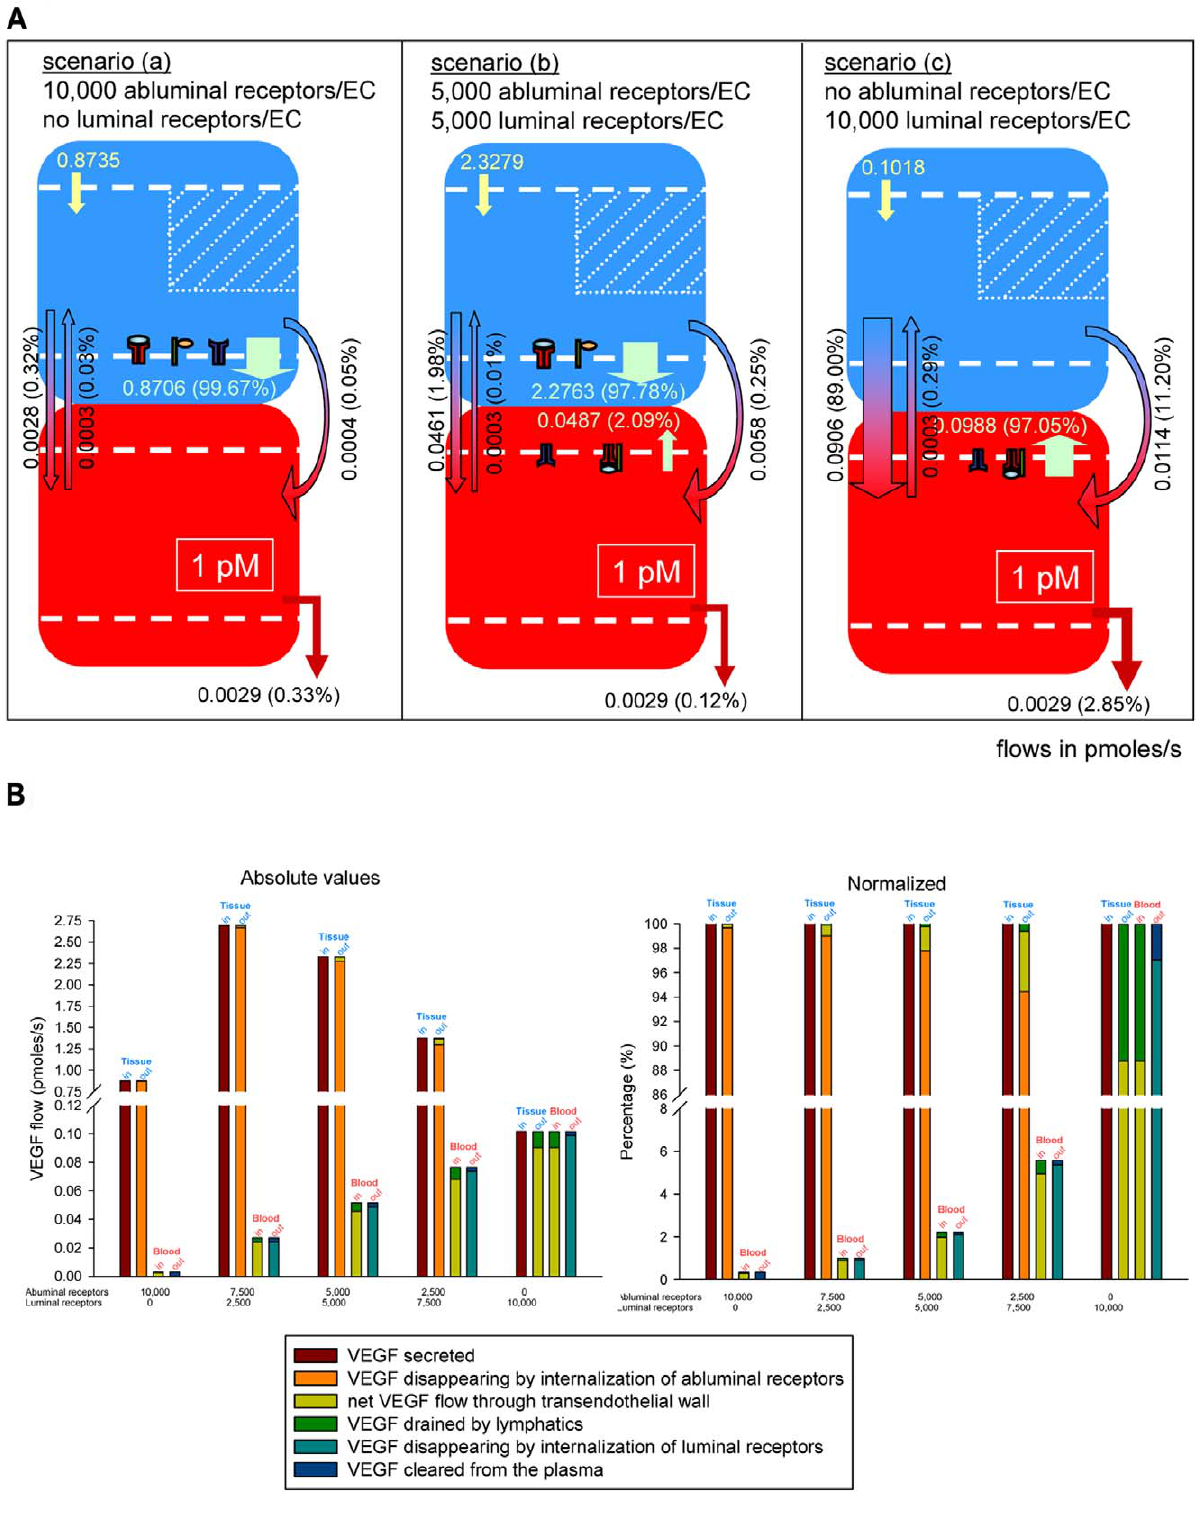
Figure 6. Flow diagrams for a total receptor density of 10,000 per endothelial cells. A. The density of total (luminal and abluminal) receptors per endothelial cell is fixed at 10,000 (VEGFR1:VEGFR2:NRP1 expression is 1:1:1). Scenario (a): all the receptors are located on the endothelial abluminal surface (yellow circle on Figure 4A); scenario (b): the receptors are evenly distributed between the luminal and abluminal endothelial surface (purple circle on Figure 4A); scenario (c): all the receptors are located on the endothelial luminal surface. Numbers represent absolute values of VEGF flows expressed in pmoles/s. Percentages of VEGF secretion in parentheses. B. Generalization of particular cases shown in A. The density of receptors varies between 0 and 10,000 receptors per endothelial cell surface. The total receptor density is fixed at 10,000 receptors per endothelial cell. Left: absolute values; Right: percentages of VEGF secretion.